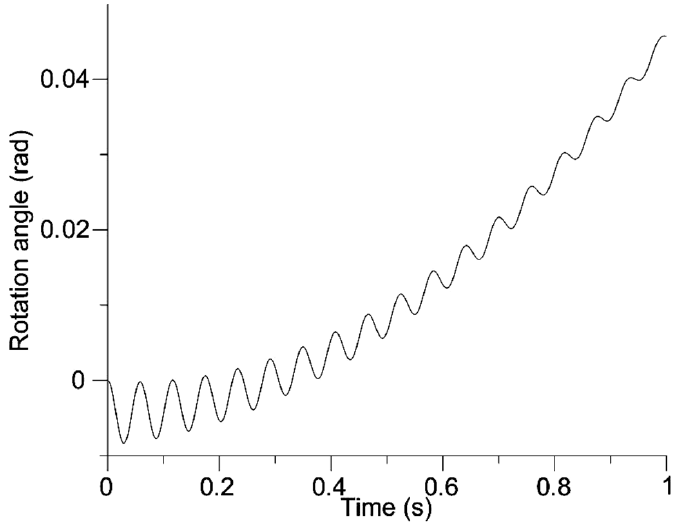
Figure 8. Instant rotation angle of the motion transmission right end in the second experiment t ∈ (0; 1) s.